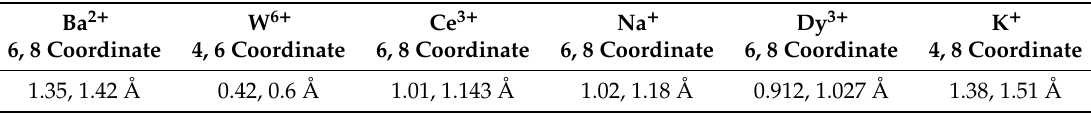
Table 3. Ionic radii data, according to Shannon [25].